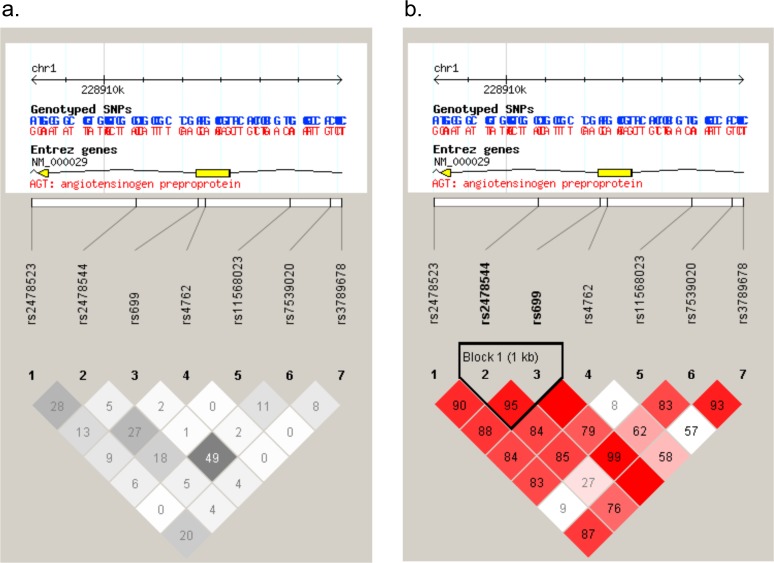
SNP locations and LD structure of AGTgene between AF group and no-AF heart disease control group.Each figure was composed of chromosome scale (the top line with even division), the transcription string (the thick bars represent exon (yellow) or UTR (blue), the thin lines represent intron), SNP scale (the hollow bar with scales representing SNPs location), and graphic of LD (black-and-white) or block definition (flammulated).The measure of LD (r2) among all possible pairs of SNPs is shown graphically according to the shade of color (a),where white represents very low r2 and scarlet represents very high r2. The numbers in squares are r2values (r2 x 100).The measure of LD (D') among all possible pairs of SNPs is shown graphically according to the shade of color (b), where white represents very low D' and dark represents very high’. The numbers in squares are D' values (D' x 100).